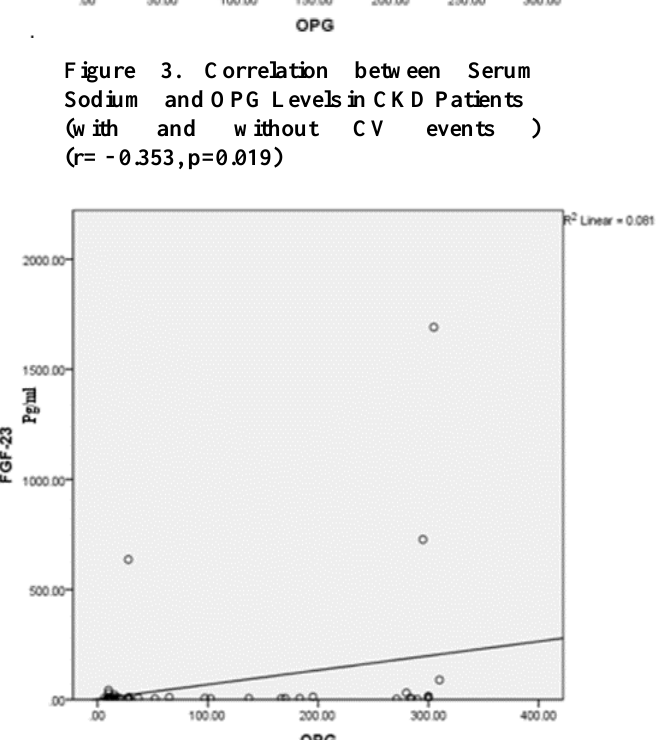
Figure 3. Correlation between Serum Sodium and OPG Levels in CKD Patients (with and without CV events ) (r= - 0.353, p=0.019)